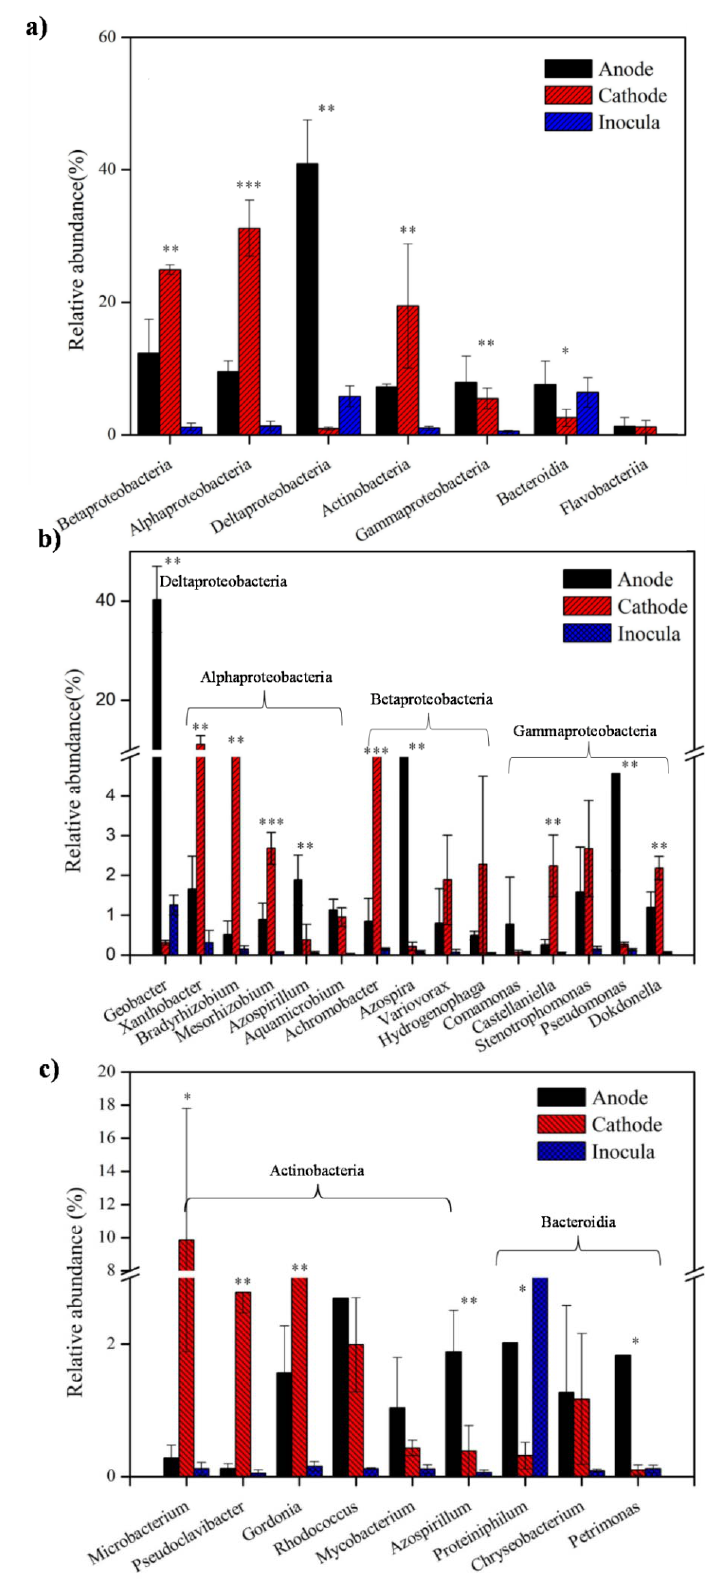
Figure 4. The relative abundance of ( a ) class-level microbial communities, ( b ) genera belonging to Proteobacteria, and ( c ) genera belonging to Actinobacteria and Bacteroidetes (Analysis of difference between anode and cathode: * p < 0.05, ** p < 0.01, *** p <